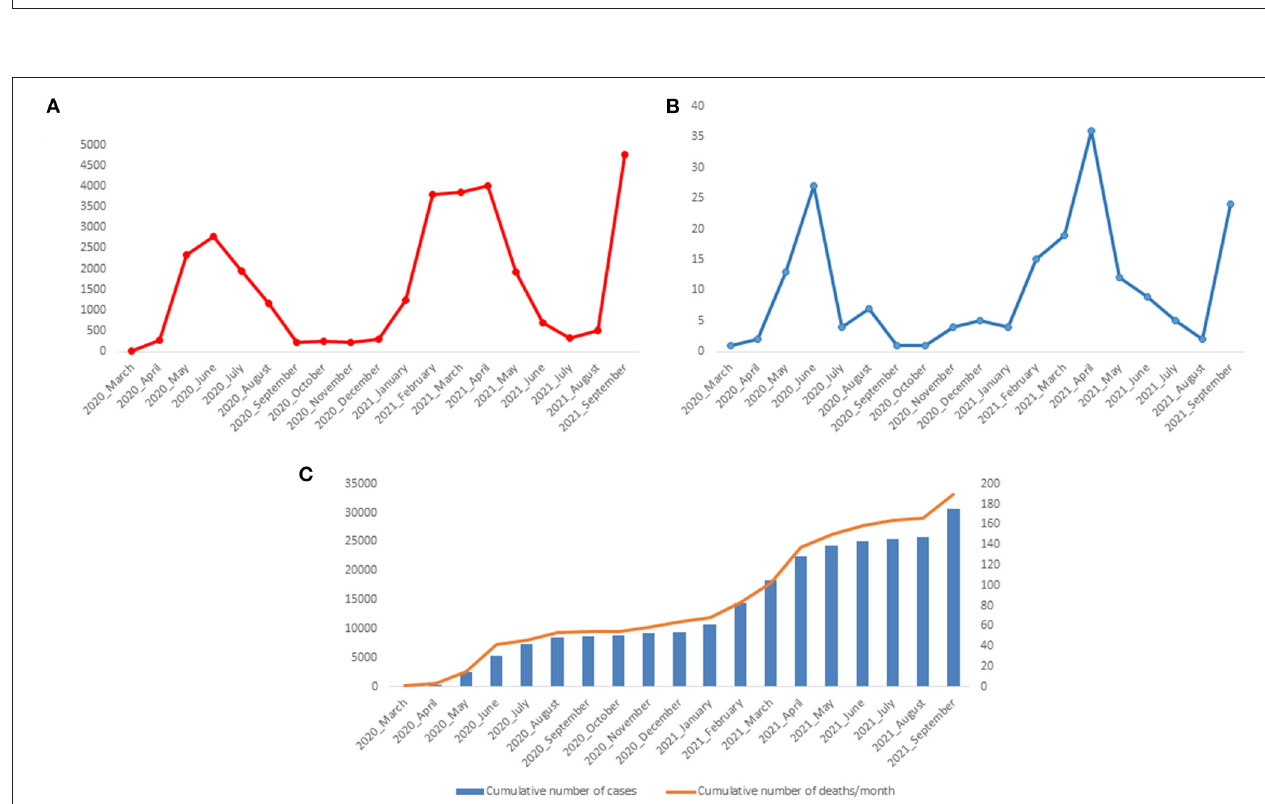
FIGURE 2 | Number of positive cases of COVID-19 and deaths between March 2020 and September 2021 in Gabon. (A) Number of COVID-19 Cases per month; (B) Number of deaths associated with COVID-19 per month; (C) Cumulative number of COVID-19 cases and SARS-CoV-2 associated deaths.